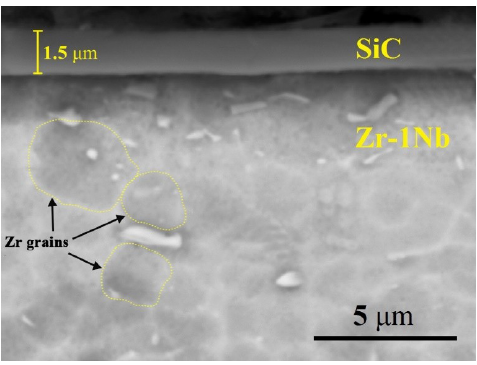
Figure 1. Typical cross-section SEM images of SiC-coated Zr-1Nb alloy.